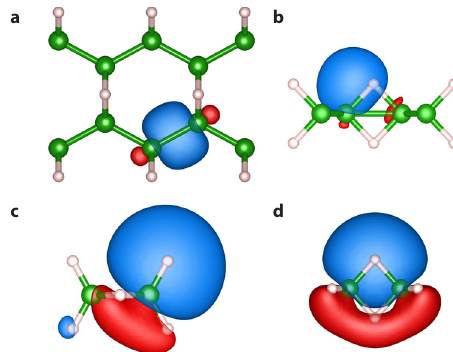
Fig. 7 MLWFs on the HB sheet. The isosurfaces of the MLWFs on the HB sheet ( a , b ) and B 2 H 6 ( c , d ) are shown. Only the inequivalent MLWFs are shown. Blue (red) surfaces indicate positive